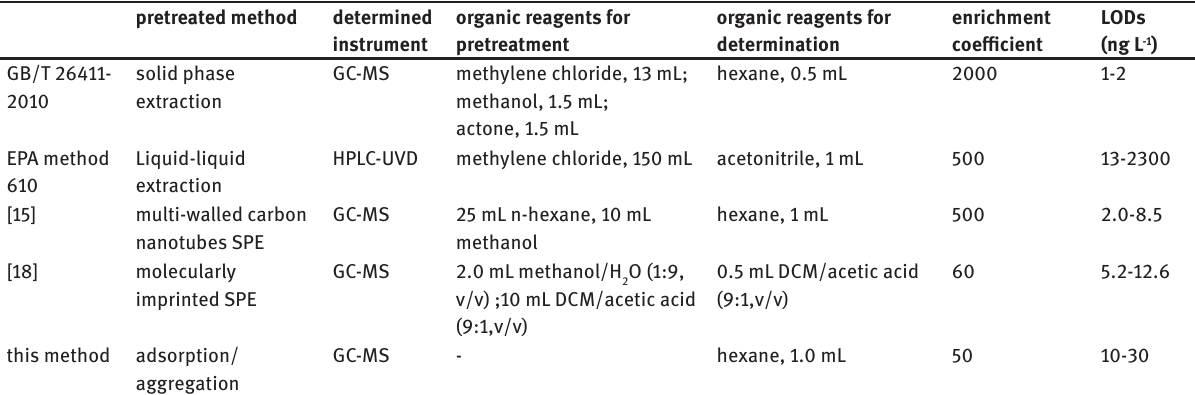
Table 3: Comparison of the features of the proposed method and the standard methods. pretreated